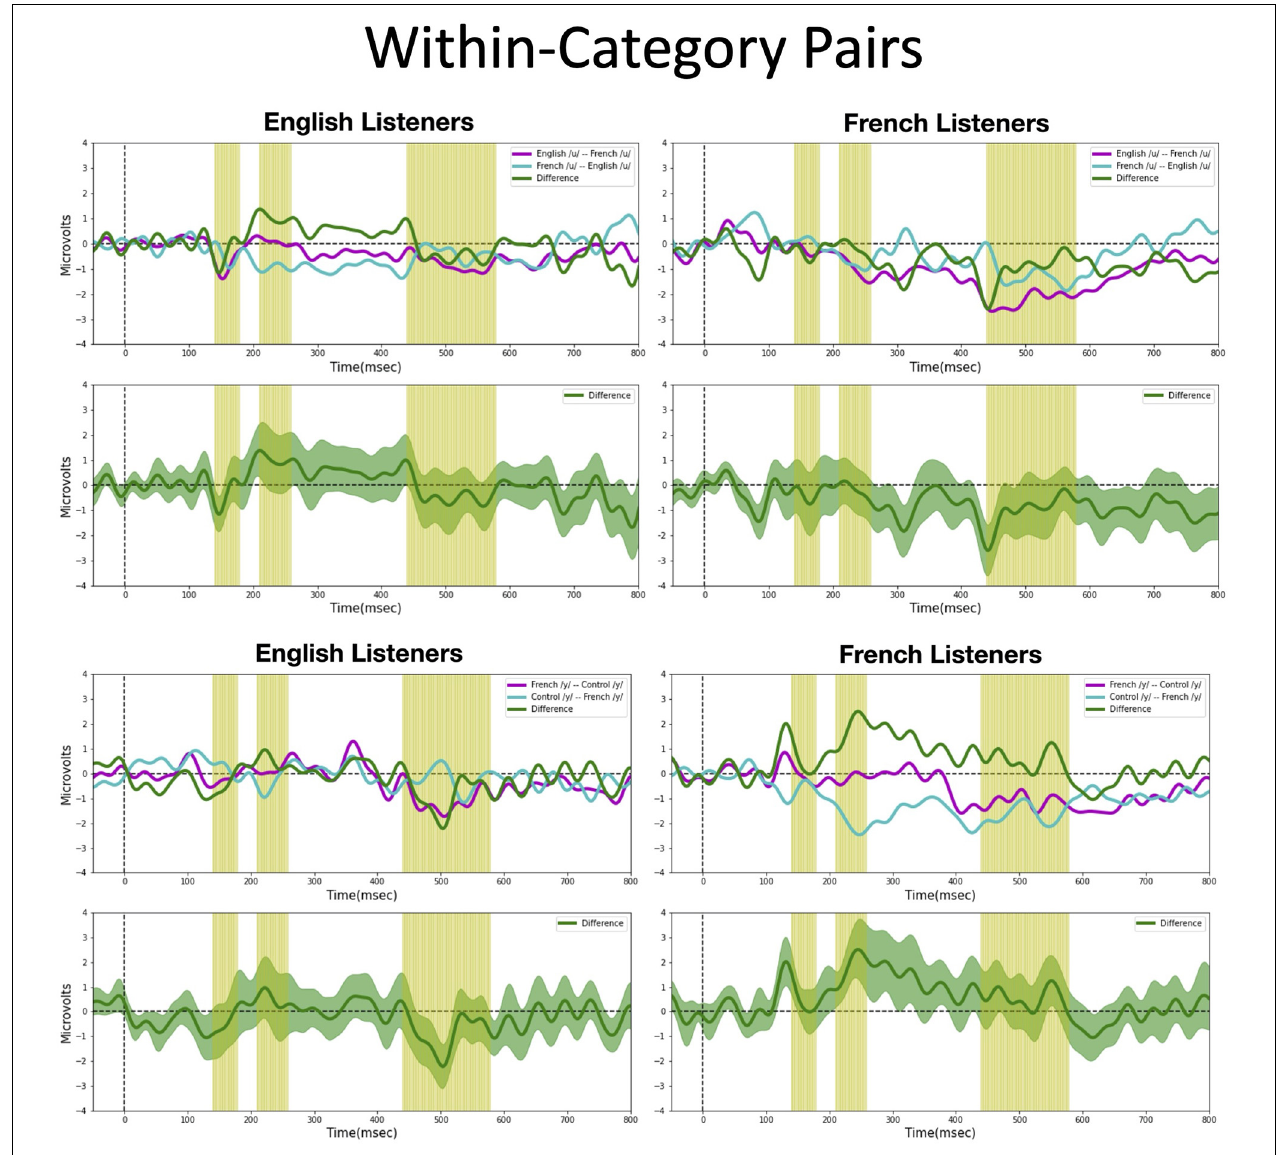
FIGURE 6 | Mismatch negativities (as described in Figure 3C ) for each stimulus type: Within-category pairs , the mean MMNs for each stimulus presentation order (purple and turquoise lines) and difference waveform (green lines) (in the top half of each panel) and the difference waveform plotted with the standard error for the group (as the dark green shaded region) in the bottom half of each panel. The light green shading indicates the pre-selected time windows used in the hypothesis-based anayses. The MMNs are plotted for each language group wth English Listeners on the left and French Listeners on the right. The vowel pair for each MMN is indicated in the legend at right hand corner of each panel with the standard followed by the deviant (e.g., French /y/ – French /u/ denotes an MMN with French /u/ (V1) as the deviant in the context of French /y/ (V4) as